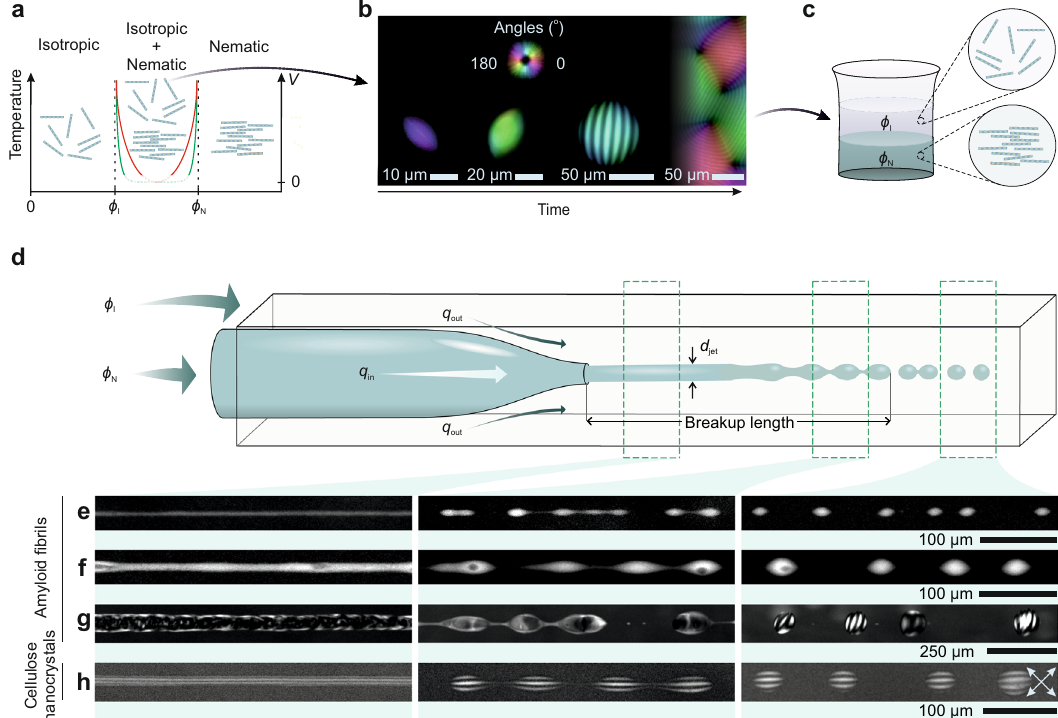
Fig. 1| Disentangling kineticseffectsfrom thermodynamicsinanisotropicbio- colloidal systems. a Phase diagram overlaid with volume-composition diagram illustrating the two Onsager branches, ϕ I and ϕ N ,for anisotropiccolloidalsystems, along with volume-composition kinetic trajectories of tactoids growing by N&G. The red and green curves sketch, respectively, the volume-composition curves of the growth process of β -lactoglobulin amyloid fi brils and sulfated cellulose nano- crystal systems with an initial concentration within ϕ I and ϕ N . The vertical axes denote the temperature for the phase diagram and the volume V for the volume- compositionspacewithinwhichthenematicphase(tactoids)emergeanddevelop. The volume-composition curves are sketches only: precise trajectories have been theoretically derived elsewhere 26 . b LC (liquid crystal)-PolScope images showing the formation of homogenous ( fi rst column),bipolar (second column),cholesteric tactoids (third column) and bulk phase (fourth column), through nucleation and growth (N&G), in a solution where the concentration is set within the coexistence